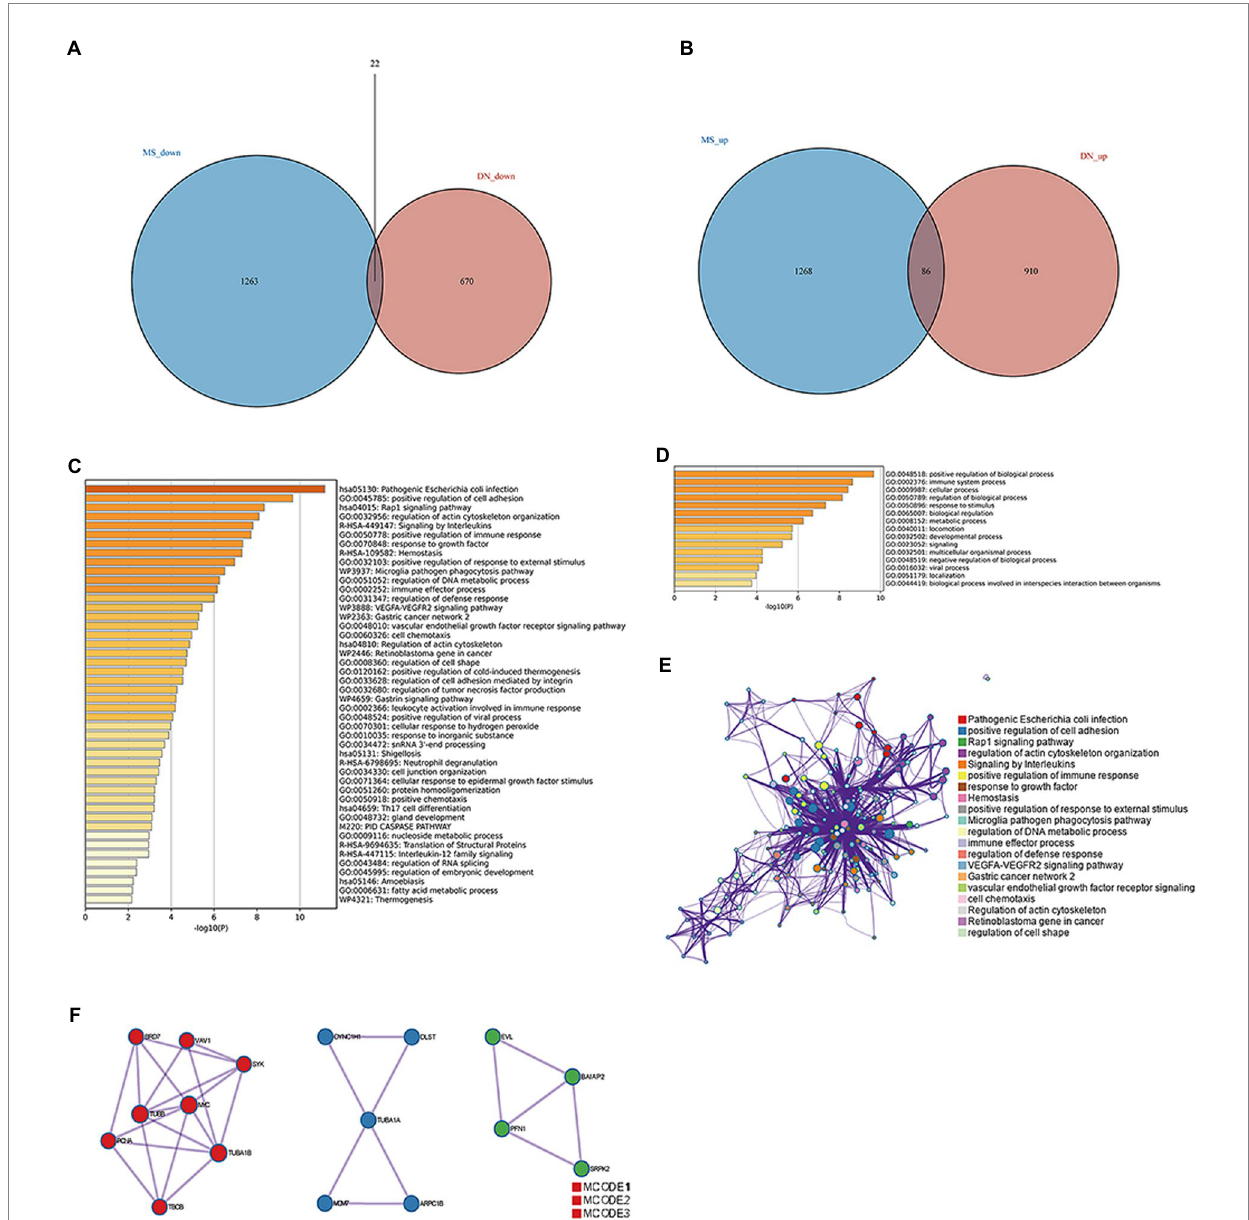
FIGURE 2 Common gene signatures in DN and MS. (A) Sixty-five upregulated genes related to DN and MS. (B) Thirty-four downregulated genes related to DN and MS. (C) The top-level Gene Ontology biological processes. (D) Up to 100 enriched clusters. (E) Network of enriched terms: Colored by cluster ID, where nodes that share the same cluster ID are typically close to each other. (F) Protein–protein interaction network and MCODE components identified in gene